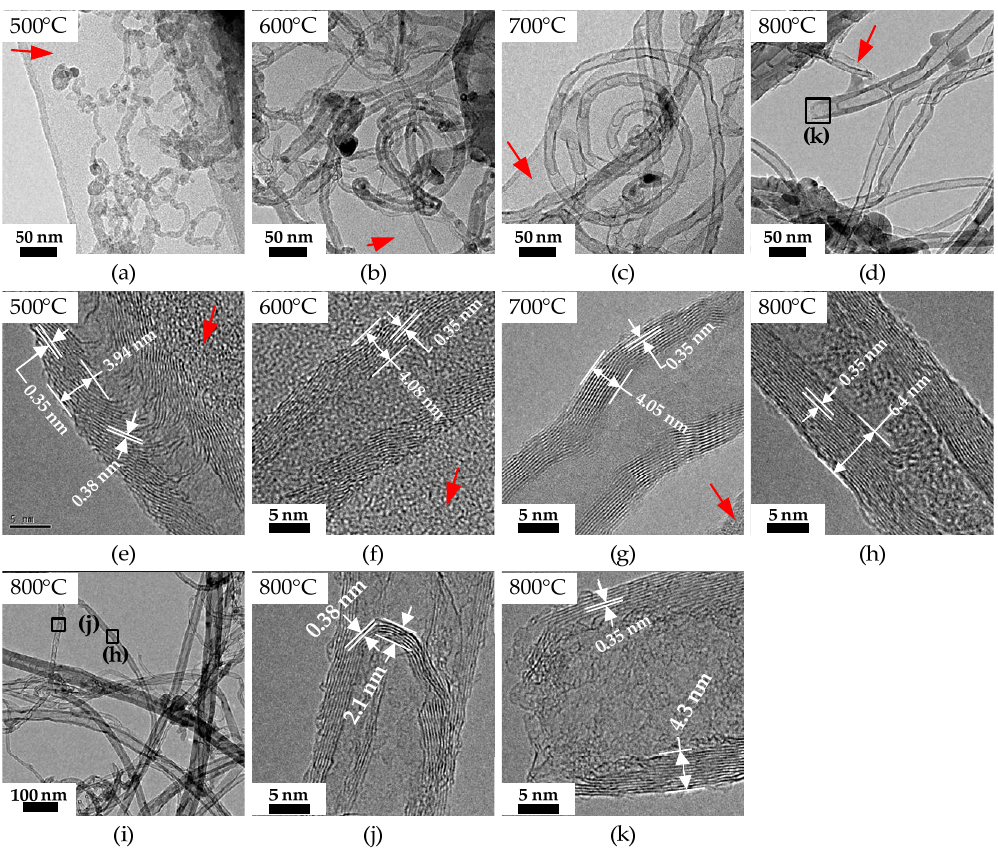
Figure 6. HRTEM images of CNTs prepared by APMCVD at the temperature of 500, 600, 700, and 800 ◦ C. ( a – d ): low magnification images; ( e – h ): high magnification images; ( i – k ): specific structure of the CNTs grown at 800 ◦ C.